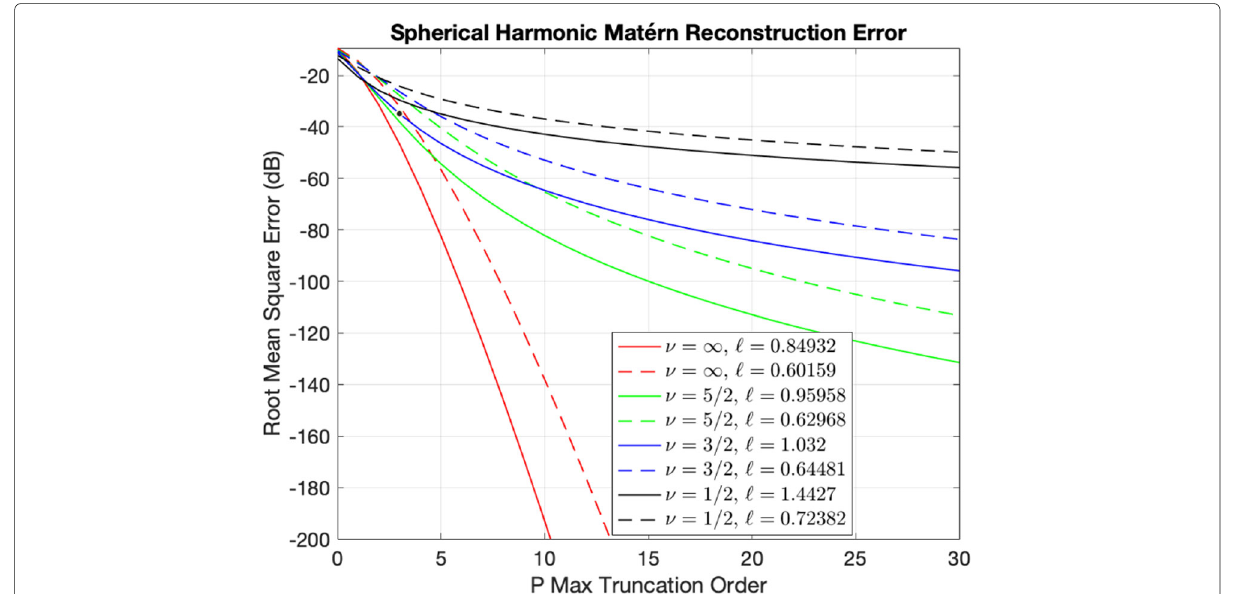
Fig. 2 RBFs with design parameters in Fig. 1 are expanded at (θ = 0, φ = 0 ) along SH bases in Eqs. 9 and 10 upto maximum truncation-order P . Their expansions are evaluated over the domain of | θ | ≤ π , φ = 0 (elevation) in Eq. 2 and the root mean square errors